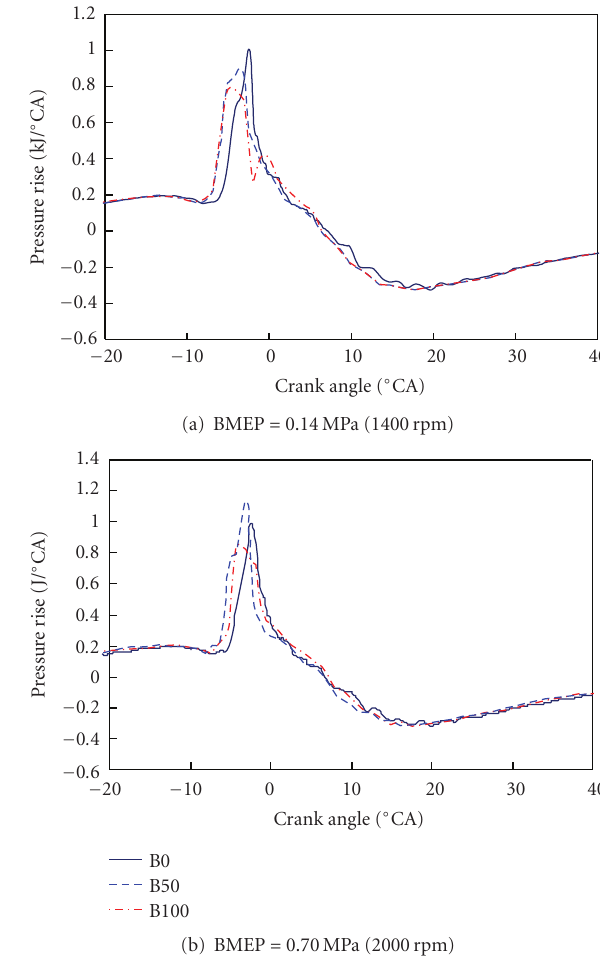
Figure 9: Diesel engine in-cylinder pressure changing rate when burning di ff erent